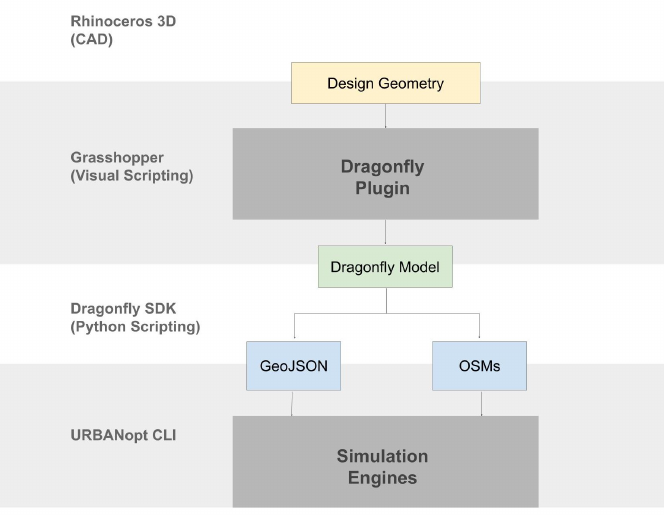
Figure 5. Dragonfly integration with Rhino/Grasshopper and